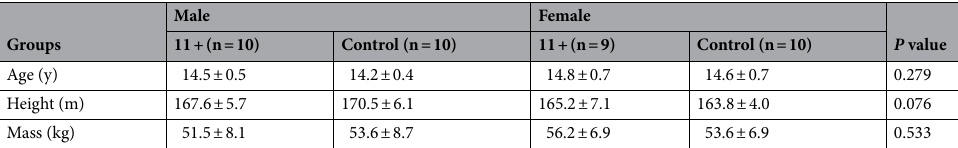
Table 3. Demographic characteristics of the participants (value are mean ± SD). y year, kg kilogram, cm centimeter, p value one-way ANOVA results among groups.